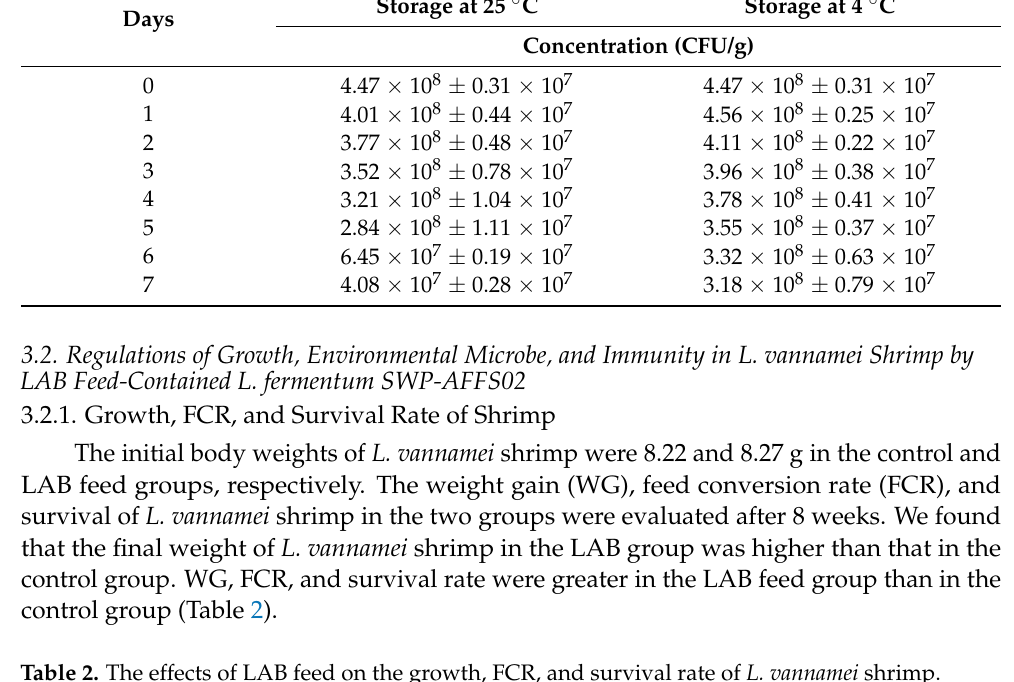
Table 2. The effects of LAB feed on the growth, FCR, and survival rate of L. vannamei shrimp.